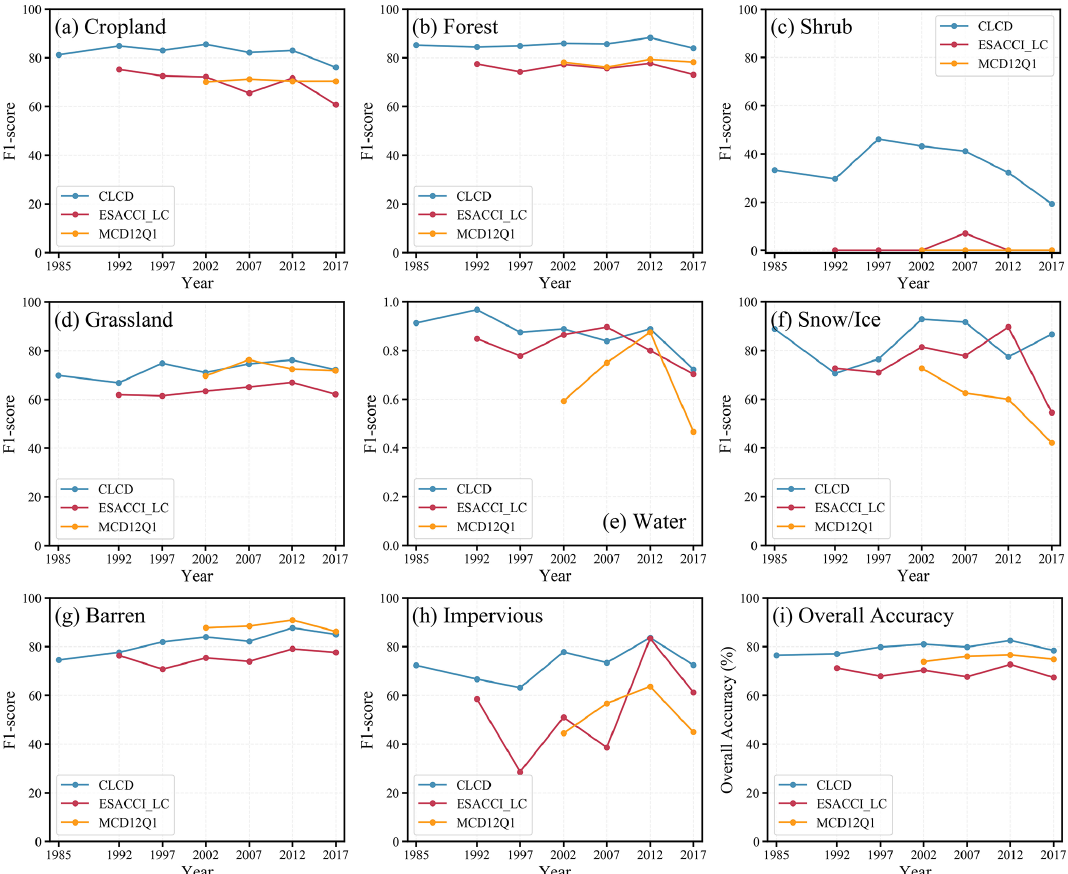
Figure 5. F1 score and overall accuracy for ESACCI_LC, MCD12Q1 and CLCD based on visually interpreted test samples.